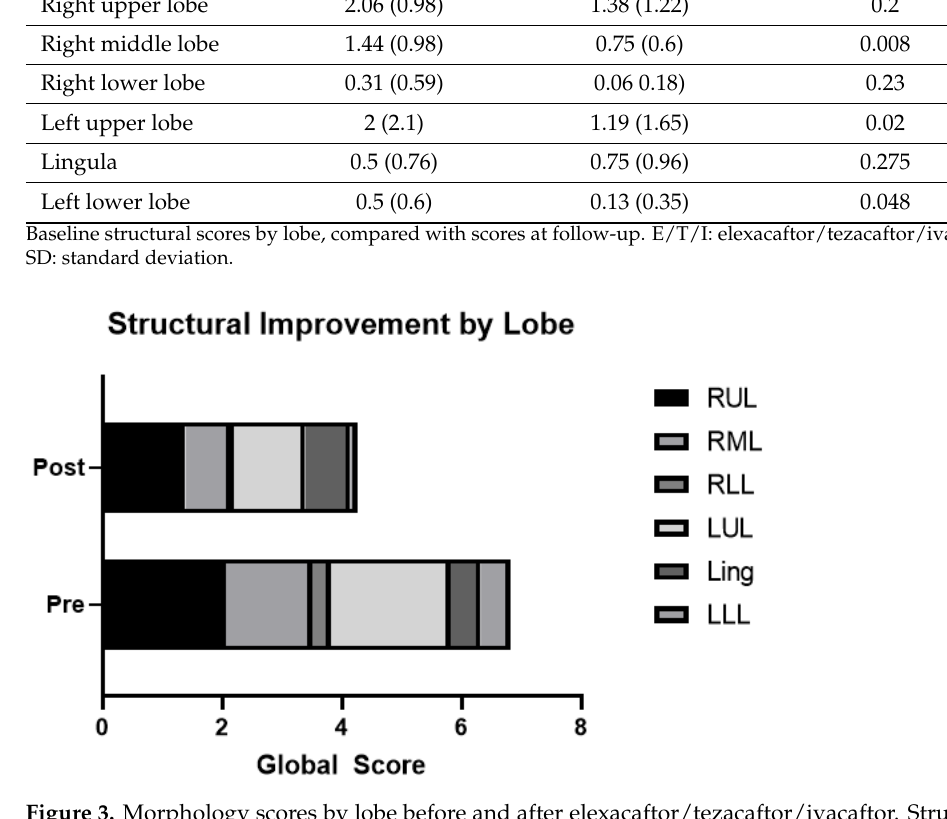
Figure 3. Morphology scores by lobe before and after elexacaftor/tezacaftor/ivacaftor. Structural improvement by lobe of lung, with higher scores representing worse disease. Ling: lingula; LLL: left lower lobe; LUL: left upper lobe; RML: right middle lobe; RLL: right lower lobe; RUL: right upper lobe.